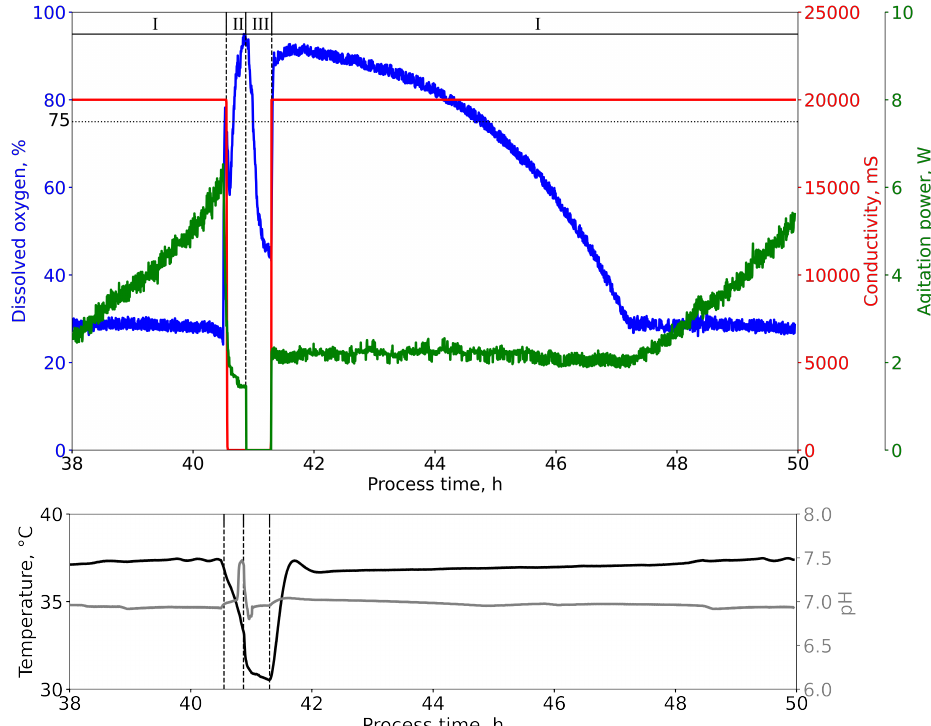
Figure 2. Process data of the transition between two consecutive batches is shown and classified into three distinct phases: the batch phase (I), the draining phase (II), and the refill process phase (III). The transition from phase (I) to (II) is triggered by a DO signal that surpasses a set threshold of 75 % air saturation. The duration of the draining process is dependent on the maximum calibrated pump rate of the respective channel. The pump is addressed with the pump rate by volume mode and parametrized with the bioreactor volume, including an additional buffer volume to ensure complete removal of the biosuspension. The transition from phase (II) to (III) is triggered by a rise in the conductivity signal over a fixed threshold of 200 mS. Agitation is automatically down-regulated during phase (II) and switched off during phase